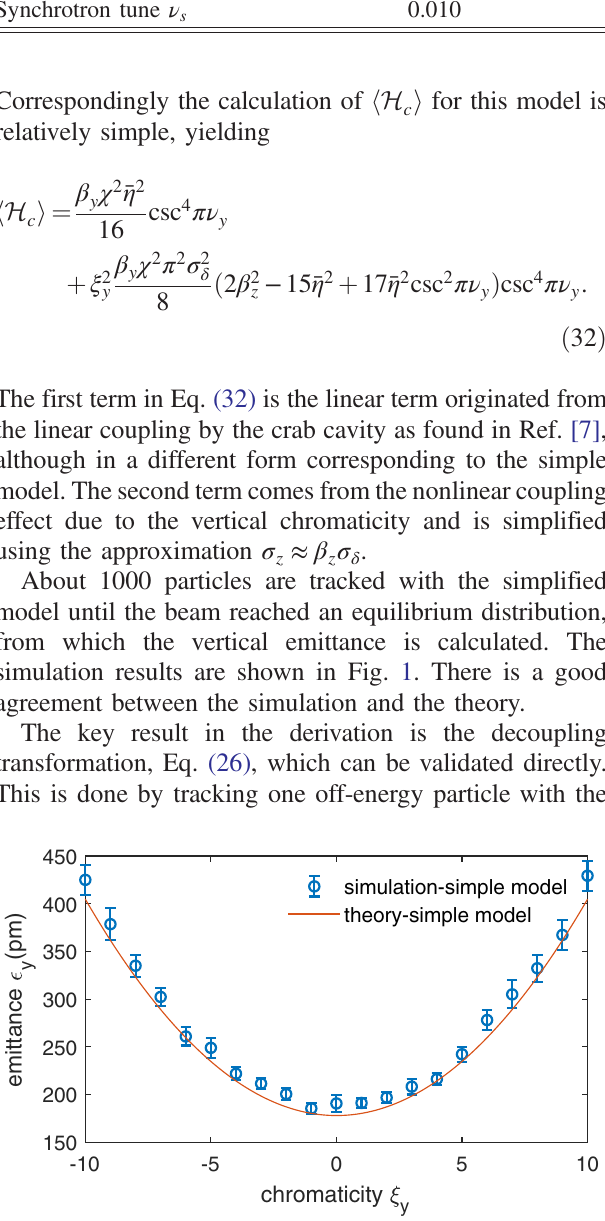
FIG. 1. Vertical emittance as a function of vertical chromaticity at vertical tune ν y ¼ 6 . 22 for the simple model, simulation compared to